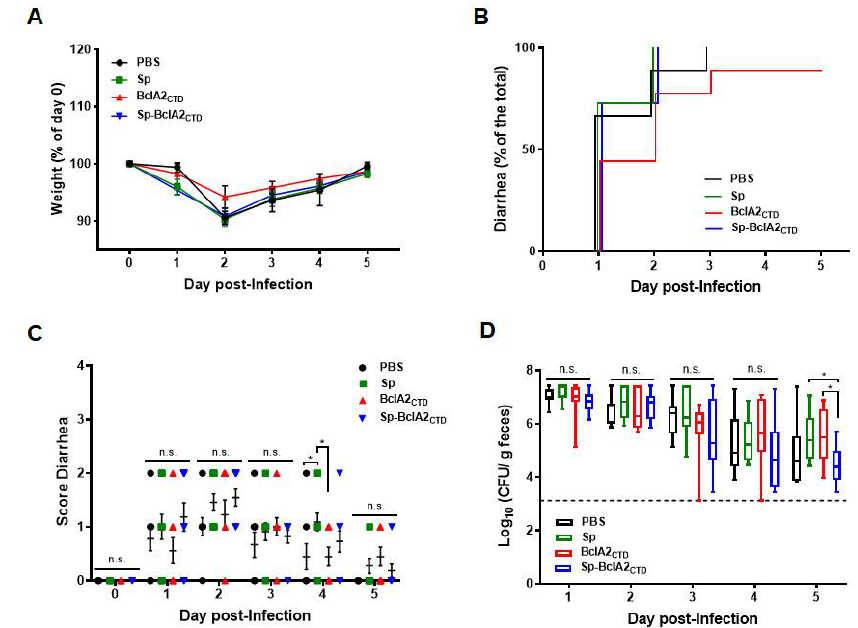
Figure 9. Challenge experiments. C57BL/6 mice were nasally immunized with PBS, spores of B. subtilis (Sp), Sp-BclA2 CTD , and purified BclA2 CTD (9 to 11 animals each group) and challenged with C. difficile R20291 spores. Mice were monitored in the following 5 d after infection for ( A ) weight loss, presented as the relative % of the weight to the day of infection (day 0); ( B ) time of occurrence of diarrhea, presented as the relative % of diarrhea in a group to the total mice; ( C ) score of diarrhea per day; and ( D ) number of C. difficile spores in feces (represented as log 10 CFU/g of feces). Differences between groups were assessed by two-way ANOVA Turkey’s multiple comparison tests, and statistical differences ( p < 0.05) are indicated by asterisks. The bars are the geometric mean ± standard error of the mean.